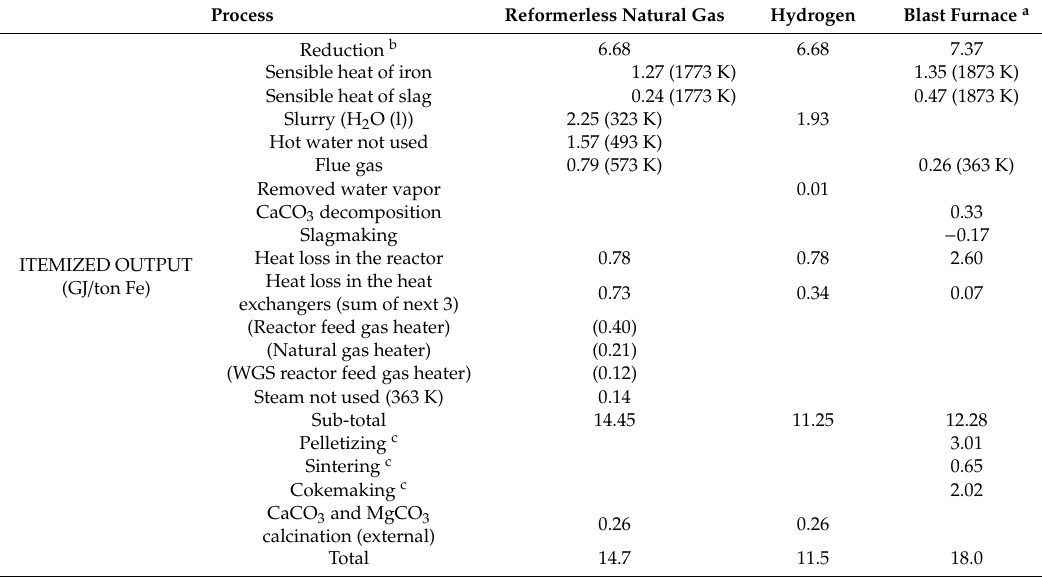
Table 4. Energy output for an industrial-scale flash ironmaking process using natural gas or hydrogen vs. an average blast furnace process (for production of 1 million tons of iron). (Adapted from Pinegar et al.